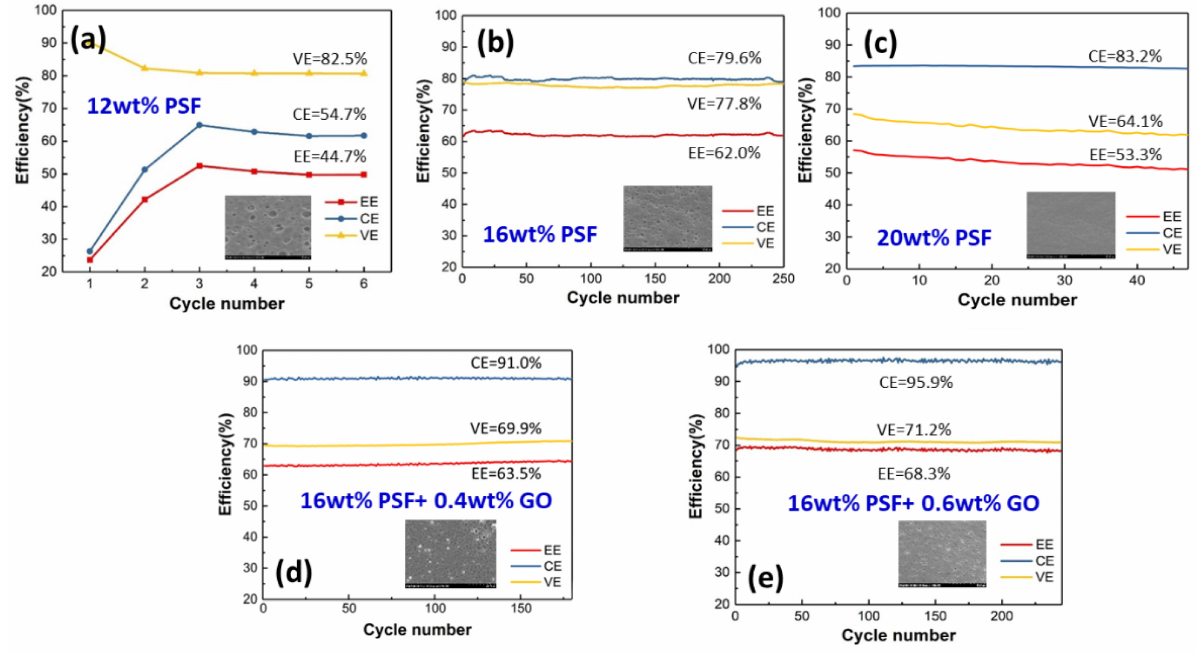
Figure 9. The charge/discharge efficiency of the ( a ) 12 wt.%, ( b ) 16 wt.%, and ( c ) 20 wt.% PSF membranes, and of the ( d ) 16 wt.% PSF + 0.4 wt.% GO and ( e ) 16 wt.% PSF + 0.6 wt.% GO membranes. The 16 wt.% PSF porous membrane with 0.4 wt.% or 0.6 wt.% GO (Figure 9d,e)